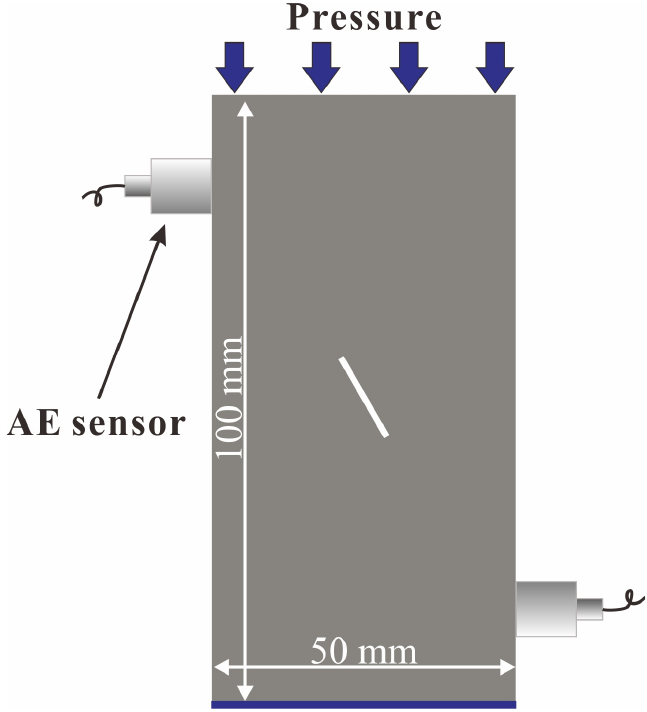
Figure 6. The boundary conditions of the model samples.